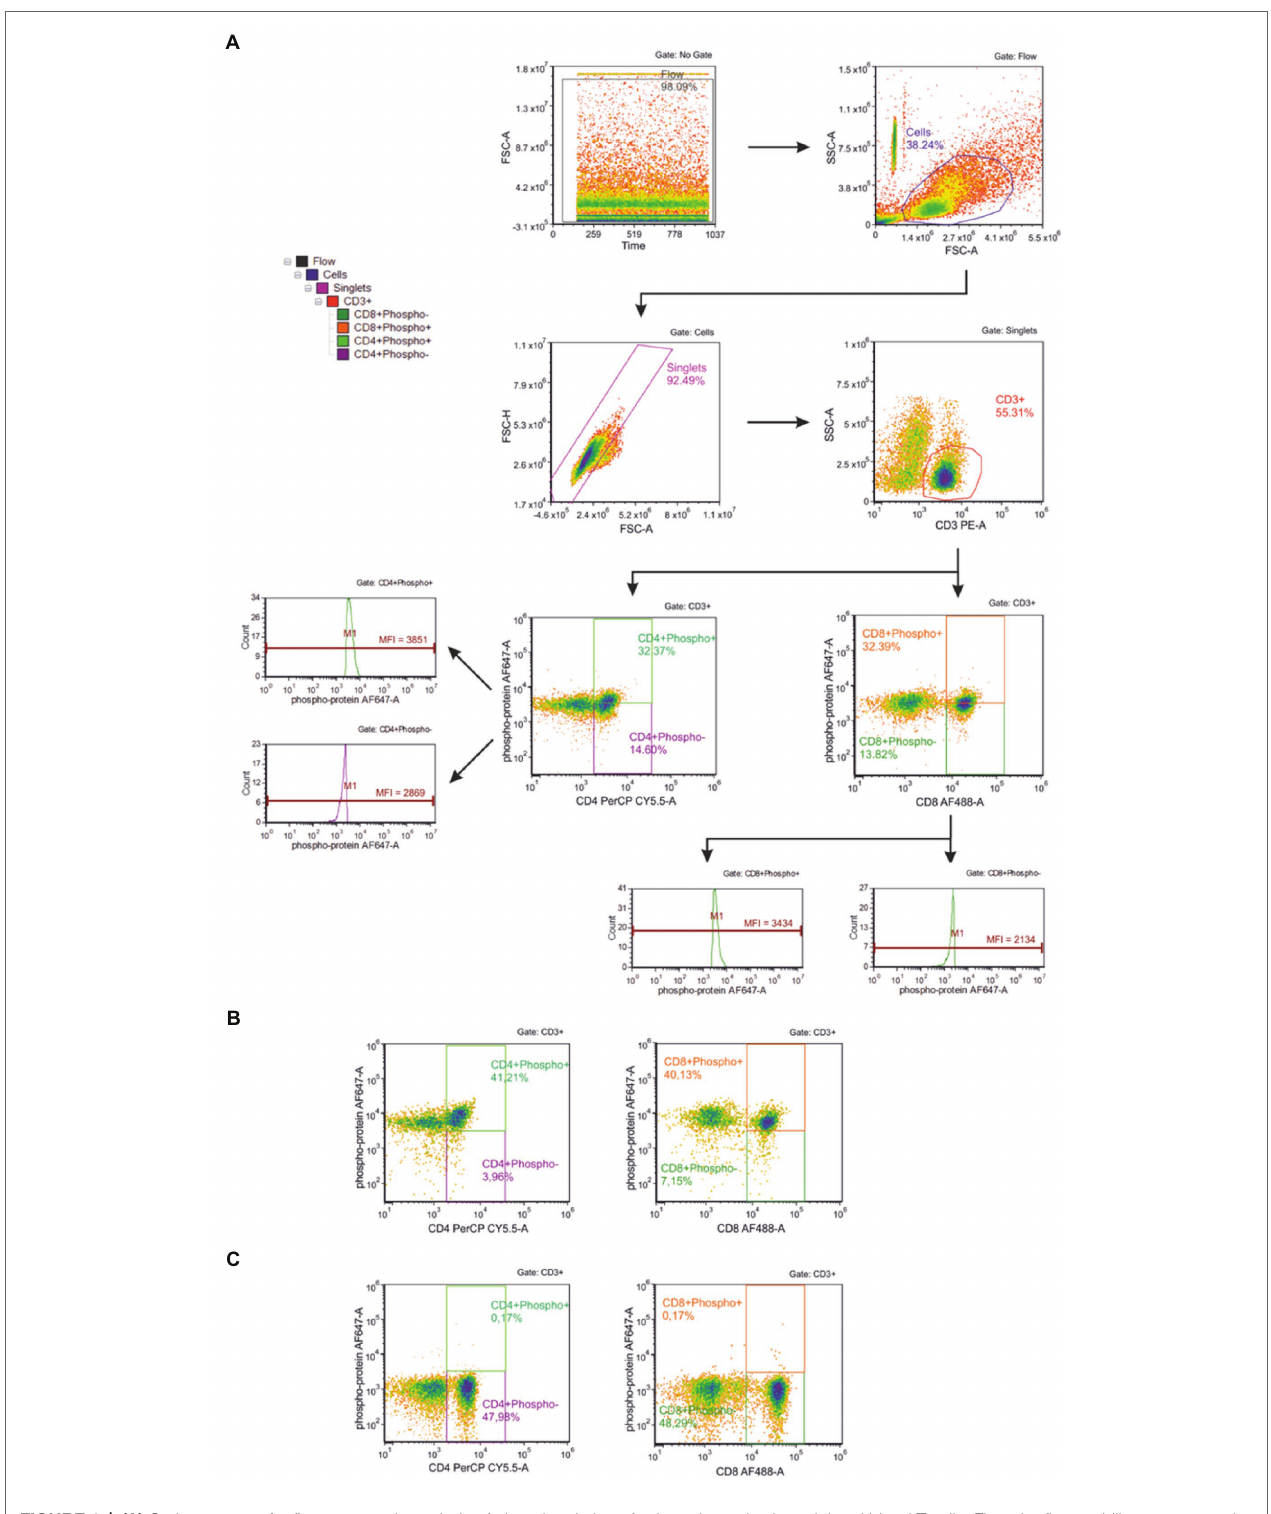
FIGURE 1 | (A) Gating strategy for flow cytometric analysis of phosphorylation of selected proteins in peripheral blood T cells. First, the flow stability was ensured. The next plot shows scatter gate to identify cell population; then a gate for doublet discrimination was used. In the next step, CD3+ (T) lymphocytes were gated and assigned as phospho-positive and phospho-negative, respectively. Then CD8+ (Tc) and CD4+ (Th) T lymphocytes were identified. These T lymphocyte subsets were used to analyze the phosphorylation level of selected proteins within Tc and Th cell subsets, respectively. Representative flow cytometry plots for positive (B) and negative (C) control provided by the assay kit manufacturer and prepared according to the